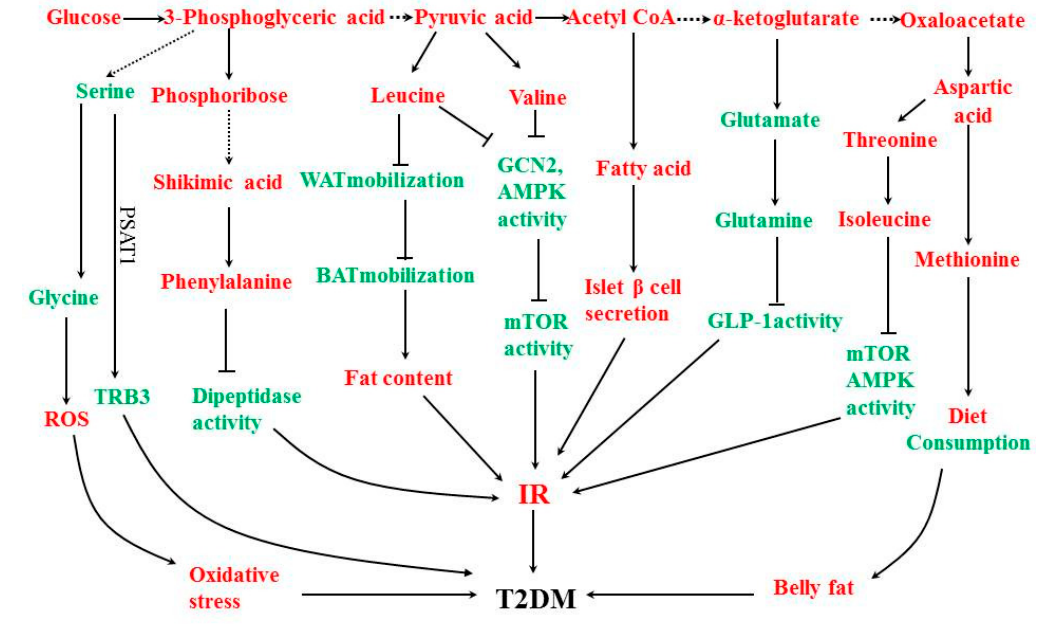
Figure 3. Metabolic pathway map.